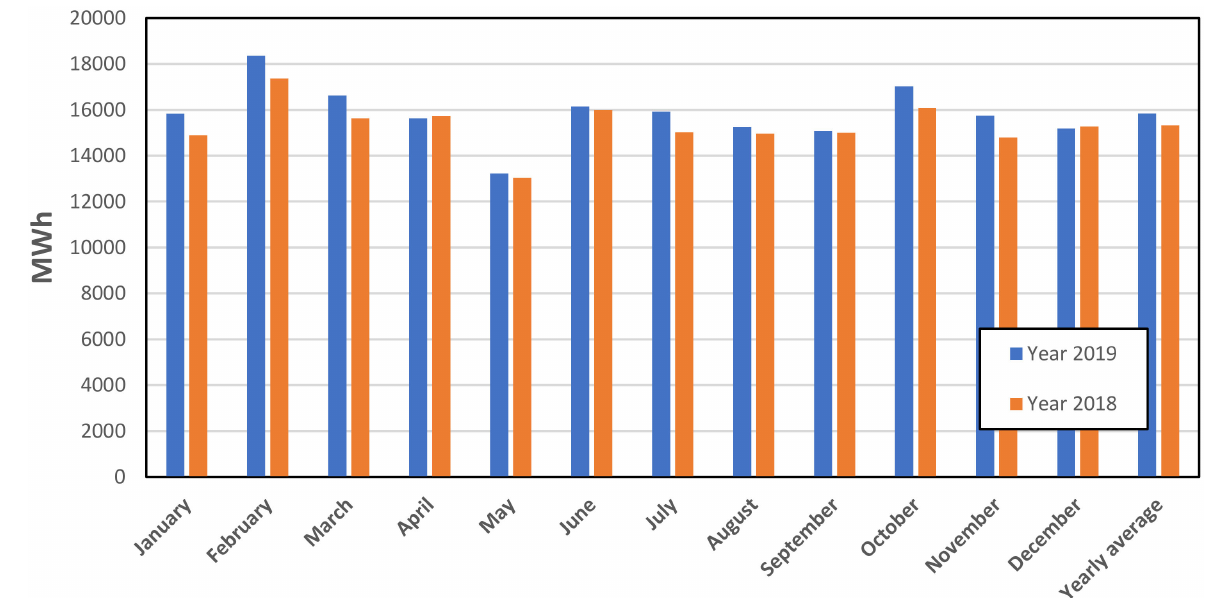
Figure 3. Monthly electricity consumption of KAU hospital.